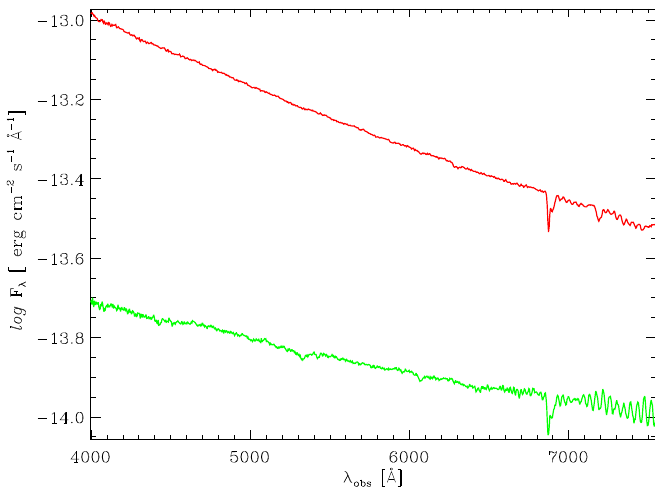
Figure 5. Two of the Mrk 421 spectra obtained at the Steward Observatory. They correspond to the maximum (red) and minimum (green) brightness states in the period 2007–2015, differing by a factor t ∼ 5 in flux